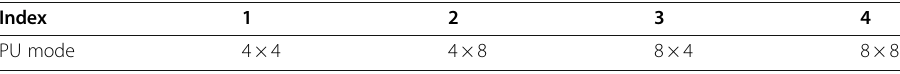
Table 1 PU partition mode for 8 × 8